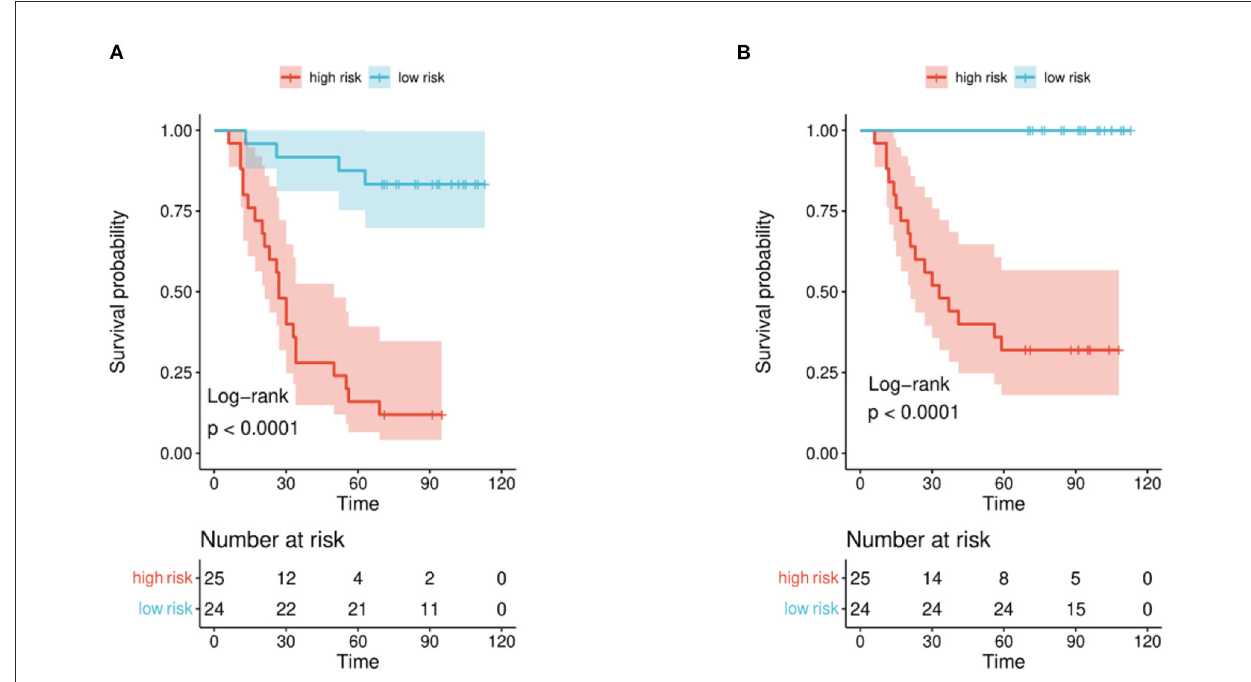
FIGURE5 Kaplan-Meier curve for patients in the validation set. Patients in the set were stratified into high-risk and low-risk groups. (A) Recurrence and (B) survival.